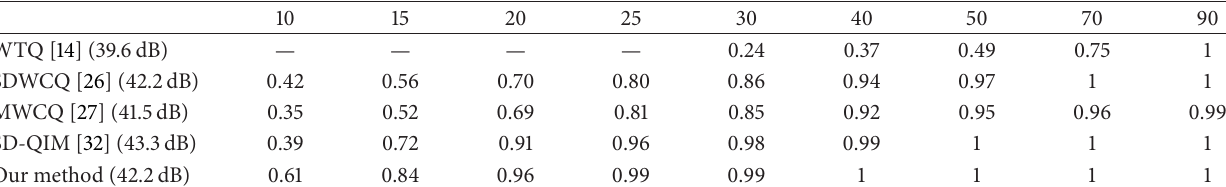
Table 2: Embedding strength versus PSNR and SSIM.